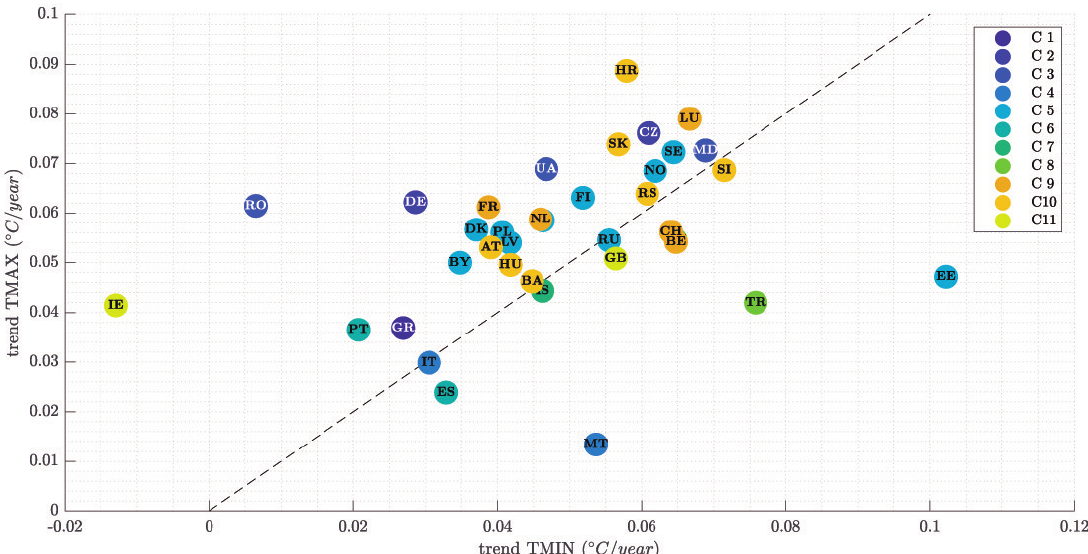
Figure 11. Scatterplot of the trends of the minimum and maximum temperatures. Each point represents a country, and colors indicate the cluster to which each point belongs according to Figure 7b. The black broken line represents the values of equal trend for minimum and maximum